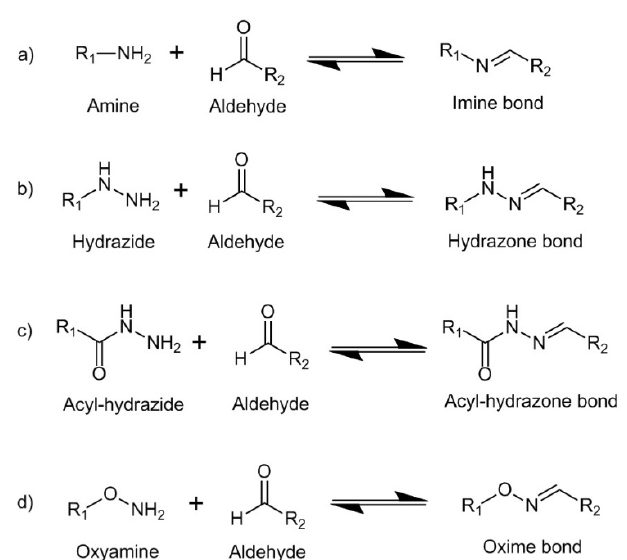
Figure 4. Reversible Schiff-base formation, ( a ) imine, ( b ) hydrazone, ( c ) acyl-hydrazone, and ( d ) oxime bonds through reactions between aldehyde groups and primary amine, hydrazide, acyl-hydrazide, or oxyamine groups, respectively.